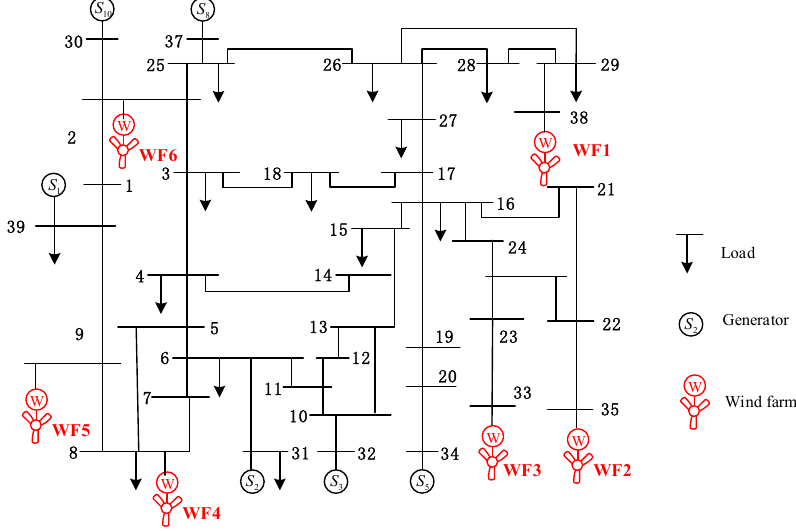
Figure 5. The modified NE 39-bus system with distributed large-scale wind farms.